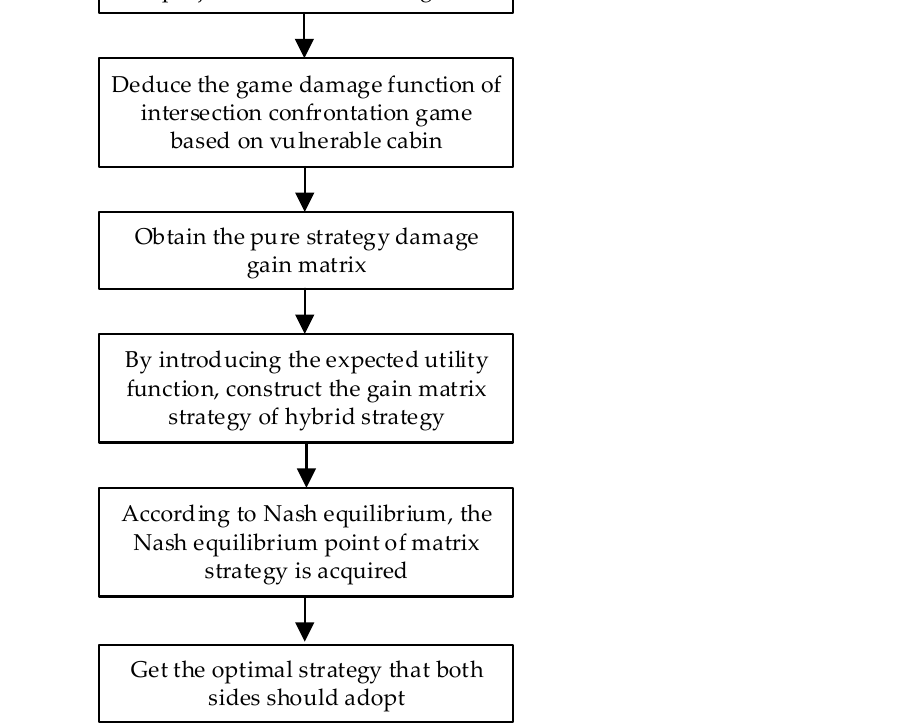
Figure 3. Flow chart of the mathematical modeling of the target damage strategy based on a two- person non cooperative game.